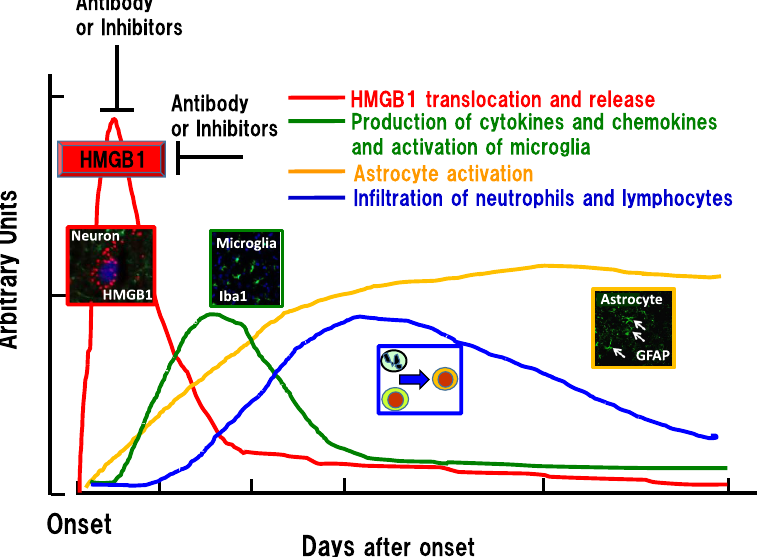
Figure 4. Time-course of inflammation-related events in the penumbra areas after ischemia, hemorrhage, and trauma. HMGB1 translocation and extracellular release form the initial peak to insults, among the known responses, which was followed in succession by microglia activation (cytokine/chemokine production), astrogliosis, and infiltration of immune cells. HMGB1 release may be a very early event that is common to several brain injuries. Inhibition of HMGB1 by the earlier intervention can lead to the diminution of the following inflammatory responses. GFAP: glial fibrillary acidic protein; HMGB1: high mobility group box-1; Iba1: ionized calcium-binding adapter molecule 1 .